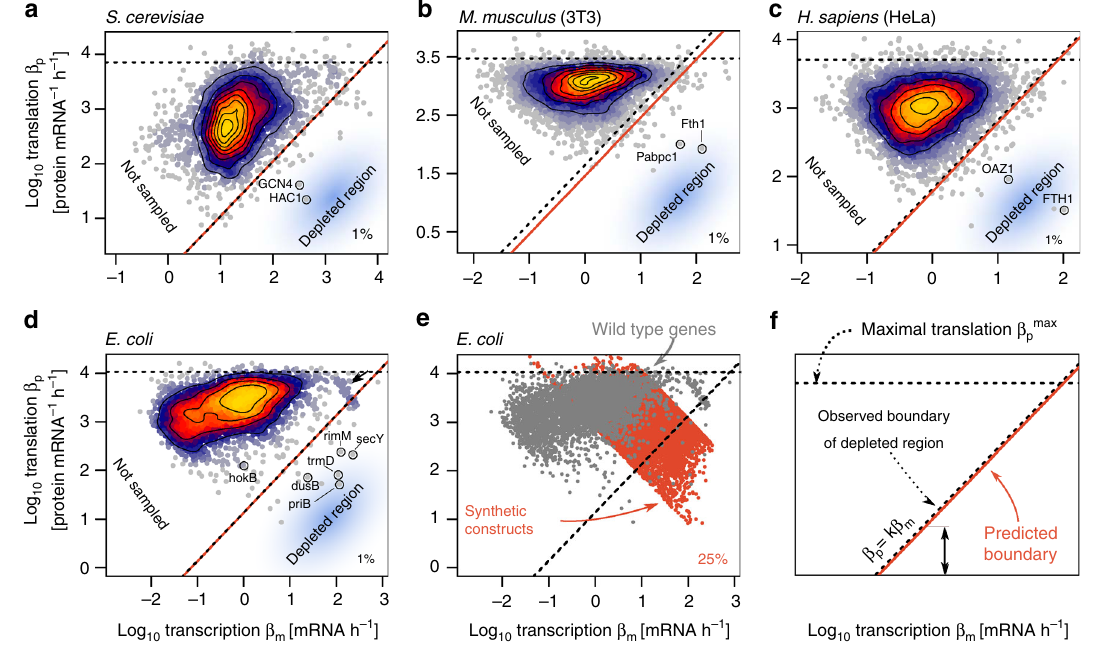
Fig. 2 Genes combining high transcription and low translation are depleted from the Crick space across organisms. a – d There is a depleted region in the Crick space of four model organisms. Transcription and translation rates were estimated from ribosome pro fi ling and mRNA sequencing data. The top (cid:1) (cid:3) is represented as a horizontal dashed line. The observed boundary of the depleted region (diagonal dashed line) has percentile of translation rates β max p slope 1 and is such that 99% of the genes have a larger translation/transcription ratio. Excluding 1% of genes in this way makes the boundary line less sensitive to measurement errors and to outlier genes, some of which are highlighted. The predicted boundary of the depleted region (red line) is according to the theory introduced later in this article. Technical constraints explain the absence of genes at low transcription and translation rates (region marked “ not sampled ” ). S. cerevisiae data ( a ) from Weinberg et al. 29 . M. musculus ( b ) and H. sapiens ( c ) data from Eichhorn et al. 30 . E. coli data ( d ) from Li et al. 3 . e Transcription and translation rates of 3744 E. coli genes (gray dots) and of 7624 synthetic constructs (red dots) of Kosuri et al. 38 . The apparent negative correlation between transcription and translation rates in this dataset is due to limits in the linear range of fl ow cytometry measurements which leads to censoring of low and high abundance proteins 38 . f Figure legend summarizing the meaning of the different lines on a – e . See also Supplementary Fig. 2